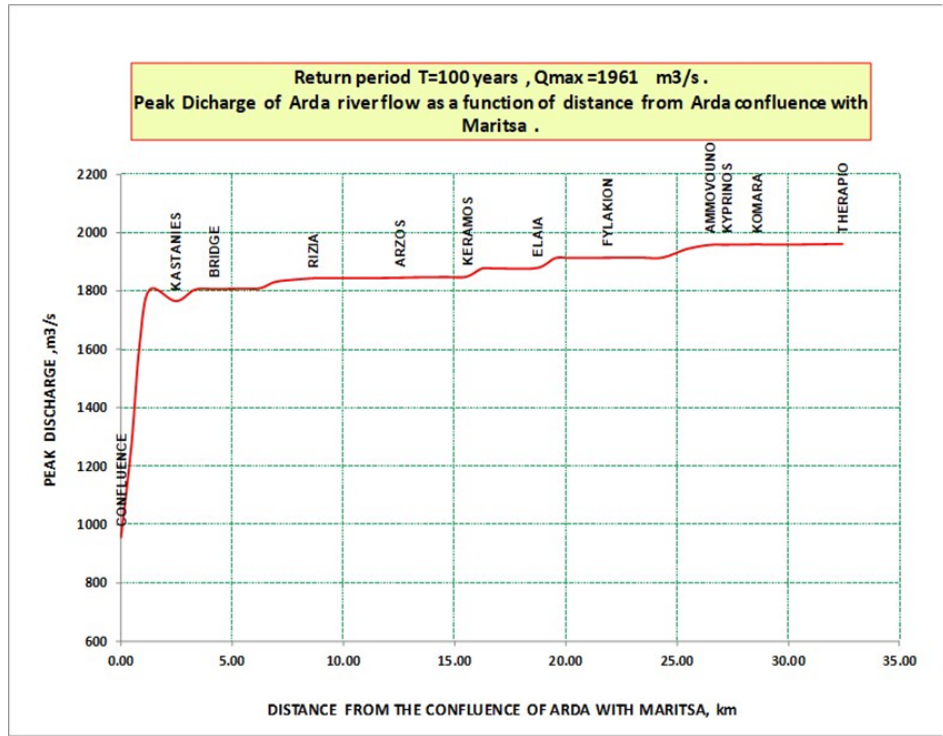
Figure 12. Maximum discharge between the levees in relation to the distance from the junction of Arda and Evros rivers. There is an upper limit of about 1000 m 3 /s for the peak discharge of Arda river entering into the Evros